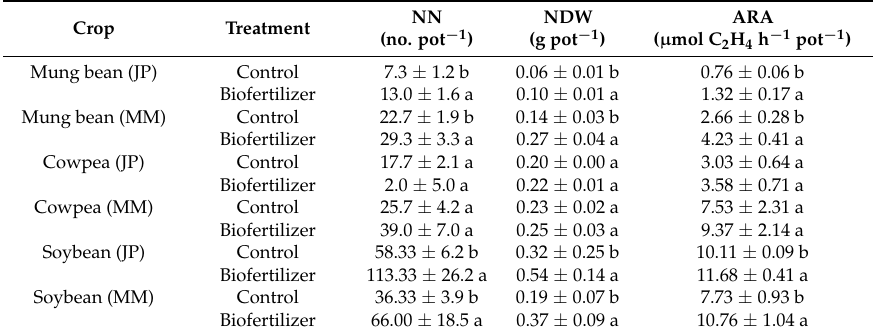
Table 5. Effect of biofertilizer on NN, NDW and ARA of mung beans, cowpeas and Soybeans at R2 (full bloom stage).